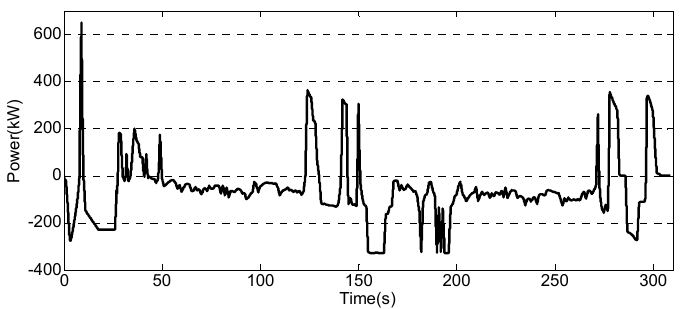
Figure 12. Experimental data for the DC bus power.